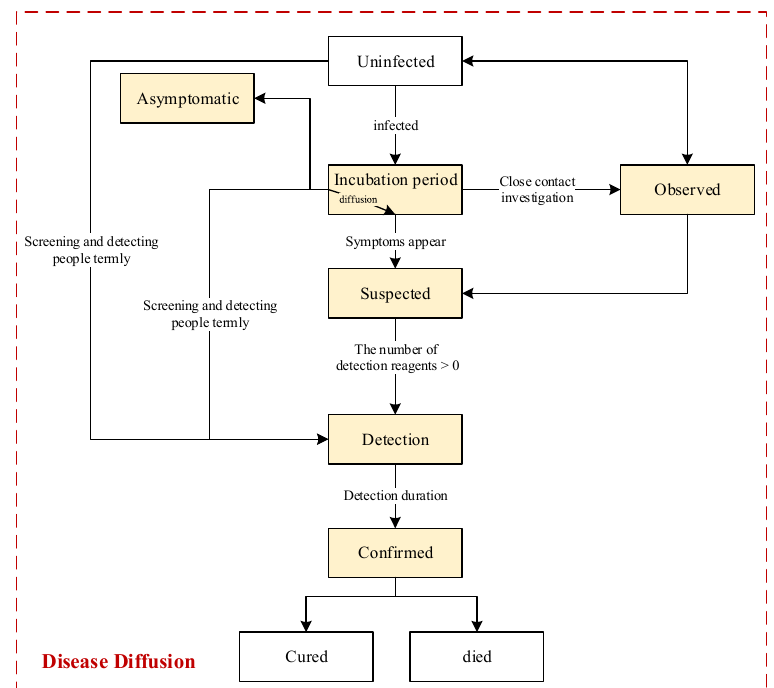
Figure 5. Flow chart of disease diffusion. The states of people will change when the transition conditions are met. The transition named “diffusion” indicates that the virus would be diffused by infected persons when they are active in the state of “incubation period”. Moreover, (1) to use as few resources as possible, only contacts of confirmed cases would be detected by close contact tracing in this mode; (2) we assume that people will have permanent immunity after being infected with the virus in this model, i.e., considering only the situation of one round of virus